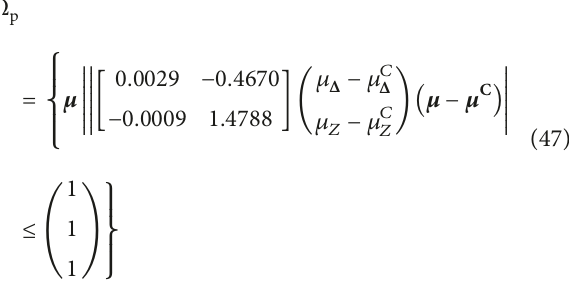
Figure 5: Sign of the minimum performance function with N 2 =1 predicted by